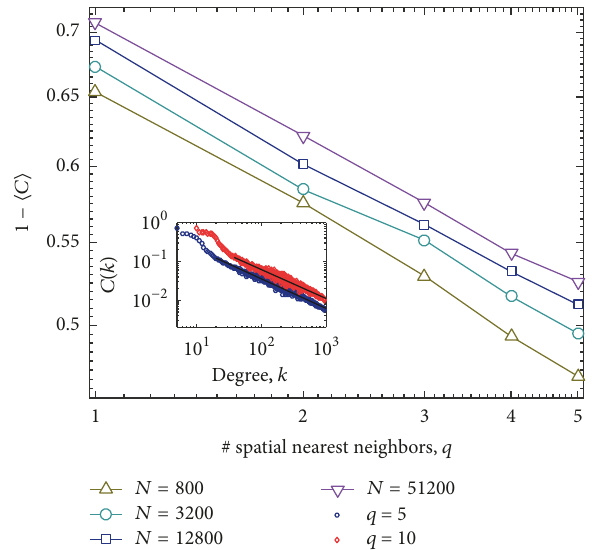
Figure 3: Dependence of the average clustering coefficient ⟨𝐶⟩ on 𝑞 , for networks of size 𝑁 = 800 , 3,200, 12,800, and 51,200 (from bottom to top). The slope of the curves in this log-log plot is roughly −0.2 . Inset: Clustering coefficient 𝐶(𝑘) as a function of node degree 𝑘 for networks of size 𝑁 = 51,200, with 𝑞 = 5 and 𝑞 = 10 . The fitted straight lines have slope ≈ −0.75 . Each data point in the figures is the result of an average over 20 independent network